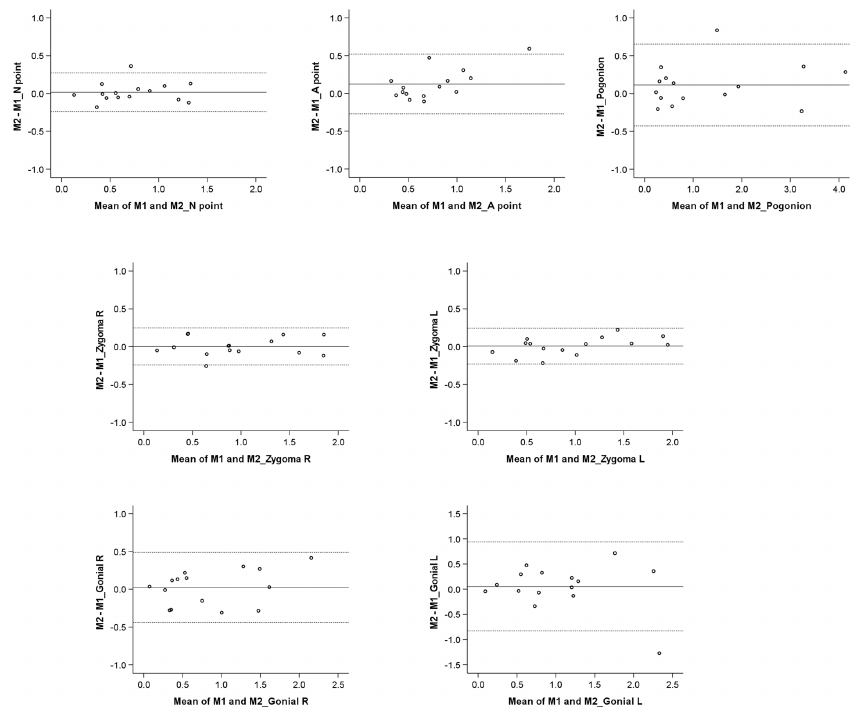
Figure 3. Bland–Altman plots on the T0–T1 changes (mm) detected through repeated EMACB superimpositions by the same operator. The continuous horizontal line shows the mean of the differences in the detected T0–T1 changes, and the dashed lines show the corresponding 95% Limits of Agreement. M1: Measurement 1; M2: Measurement 2.